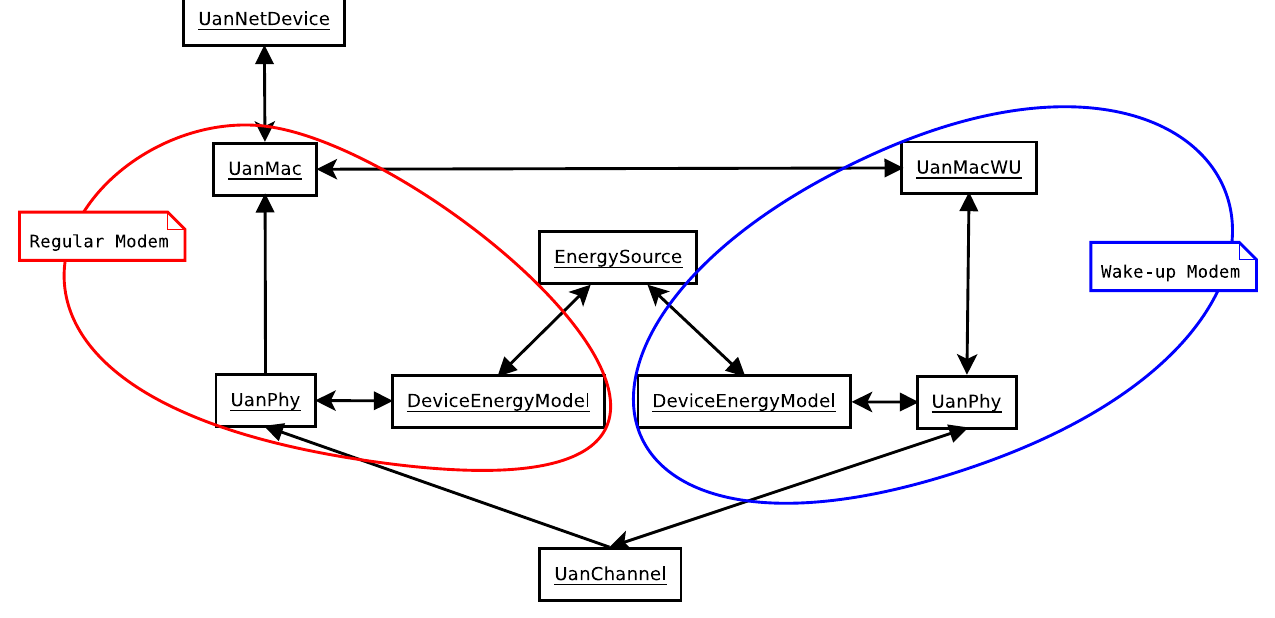
Figure 3. Simplified component diagram of the proposed underwater wake-up